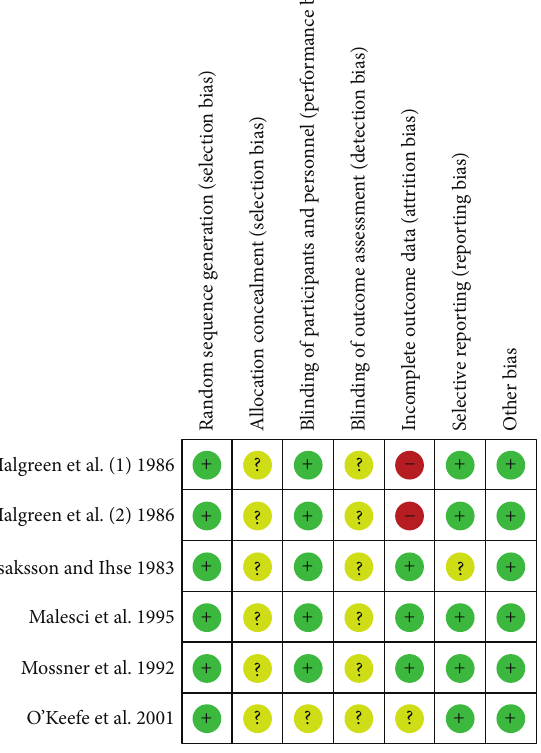
Figure 3: Consensus risk of bias assessment of the included studies. Green: low risk, yellow: unclear, and red: high